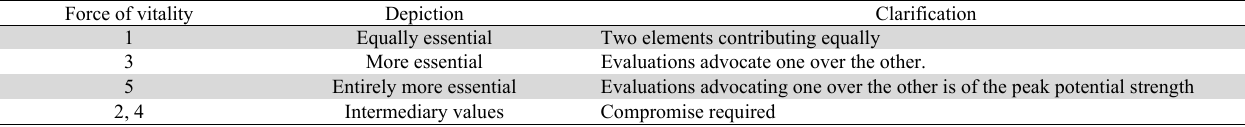
The rating scale of relative importance of factors Force of vitality Depiction Clarification 1 Equally essential Two elements contributing equally 3 More essential Evaluations advocate one over the other. 5 Entirely more essential Evaluations advocating one over the other is of the peak potential strength 2, 4 Intermediary values Compromise